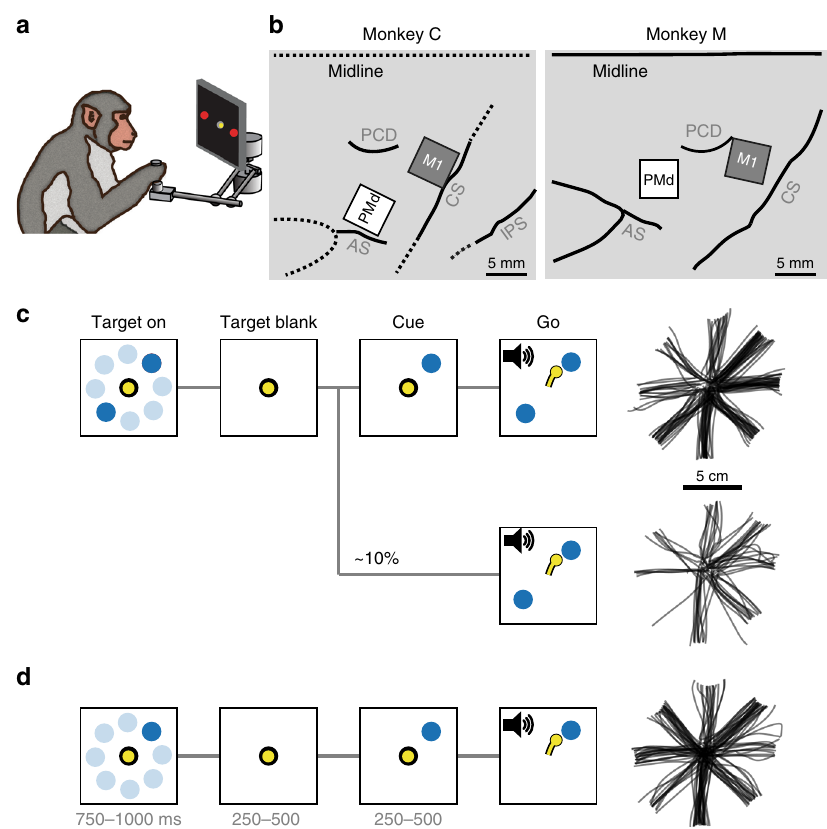
Fig. 1 Experimental setup. a Monkeys used a planar manipulandum to control a cursor. b Array placement in dorsal premotor (PMd) and primary motor (M1) cortex (CS central sulcus, AS arcuate sulcus, PCD precentral dimple, IPS intraparietal sulcus). Dashed lines correspond to approximate locations of sulcal landmarks that were obscured by the boundaries of the intraoperative craniotomy. c Task events during 2-Target trials and resulting cursor trajectories. The monkeys were initially presented with two opposing targets. On most trials (top), the correct target was displayed at the start of the Cue epoch; roughly 10% did not contain a Cue epoch (Free-Choice, bottom). On these trials, the monkeys were forced to select one of the two targets with no information about which would lead to reward. d Same as in c for 1-Target trials. The monkey image in a was created by Paul Wanda for use in this